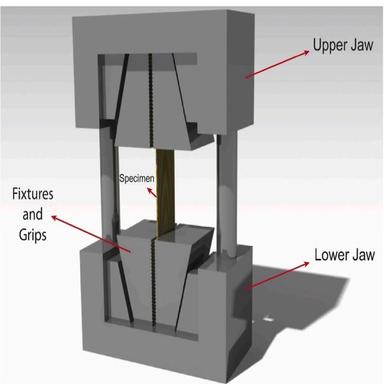
Schematic of testing set-up of compression jaw.